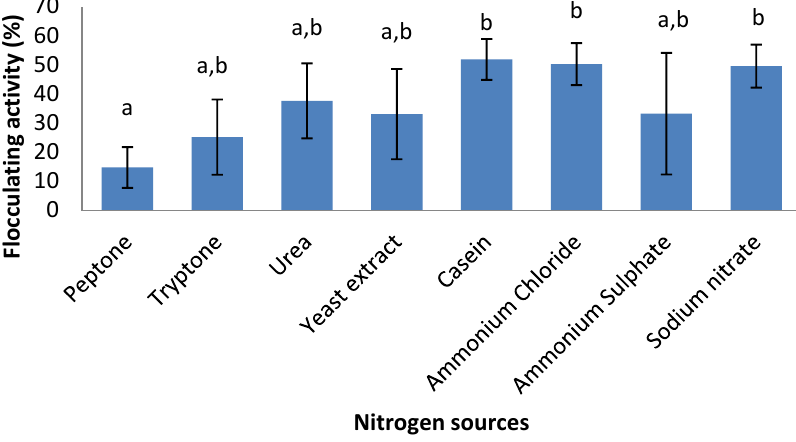
Figure 3. Effect of nitrogen sources on bioflocculant production of Cobetia sp. OAUIFE. Flocculating activities with different letters are significantly different ( p < 0.05) from each